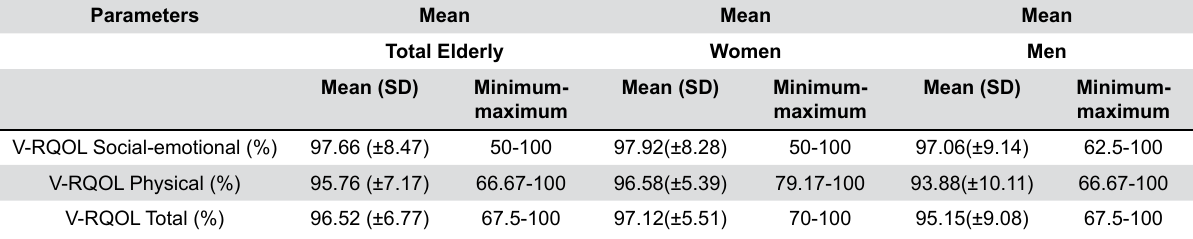
Table 1- Scores V-RQOL Protocol of men and women elderly